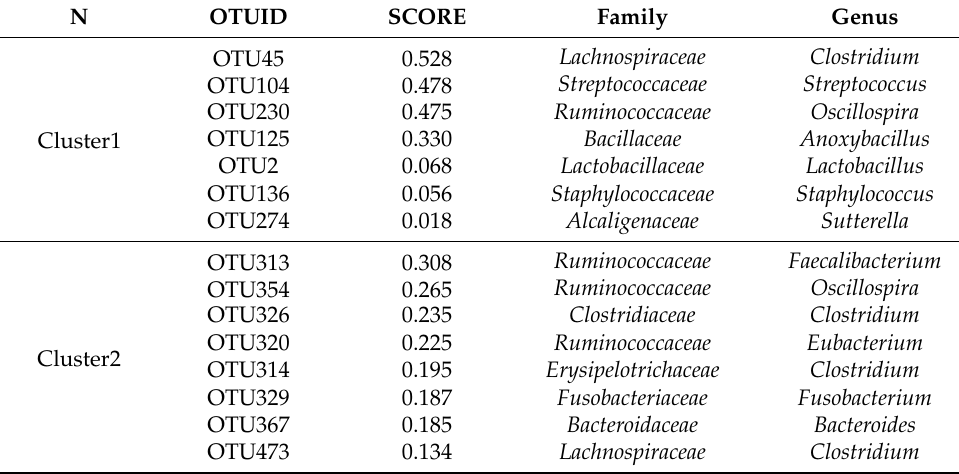
Table A4. The score value and core flora of GMPR+Spectrum in N.